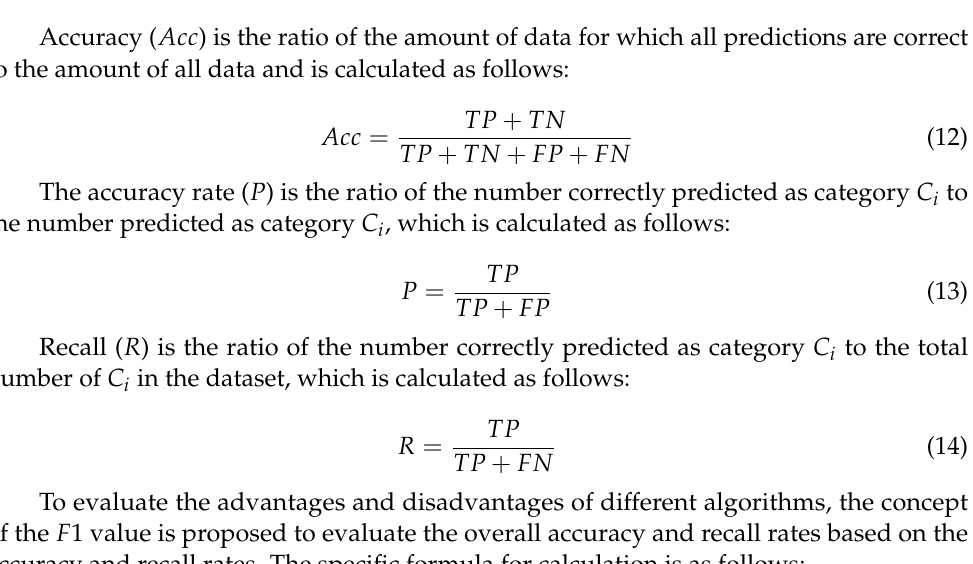
Table 4. Confusion matrix table. Predicted to Be a Positive Predicted to Be a Counter Actual Value Example Example Truth is a positive example TP FN Truth is a counter example FP